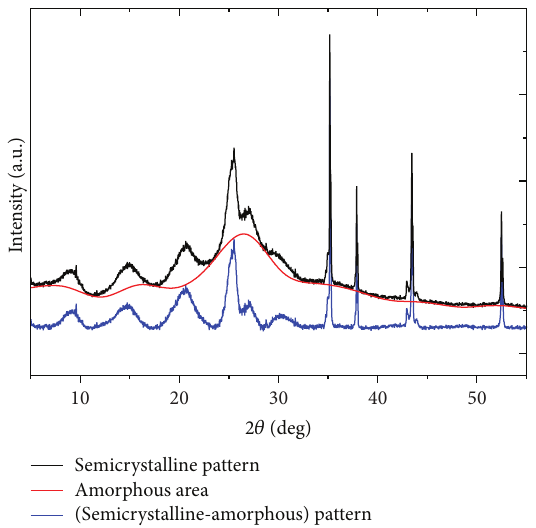
Figure 3: Decomposition of the POEA-ES diffraction peaks.